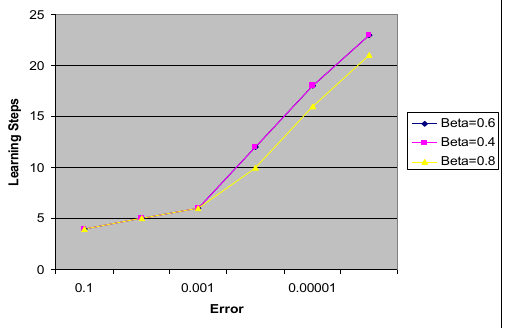
Figure 6. Learning step vs. desired error for various learning constants,  (for quant = 4 and width = 2).